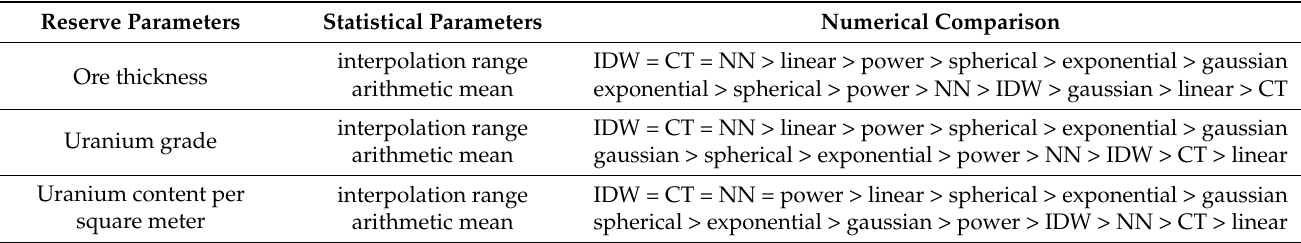
Table 1. Comparison of interpolation range and arithmetic mean of several interpolation methods.